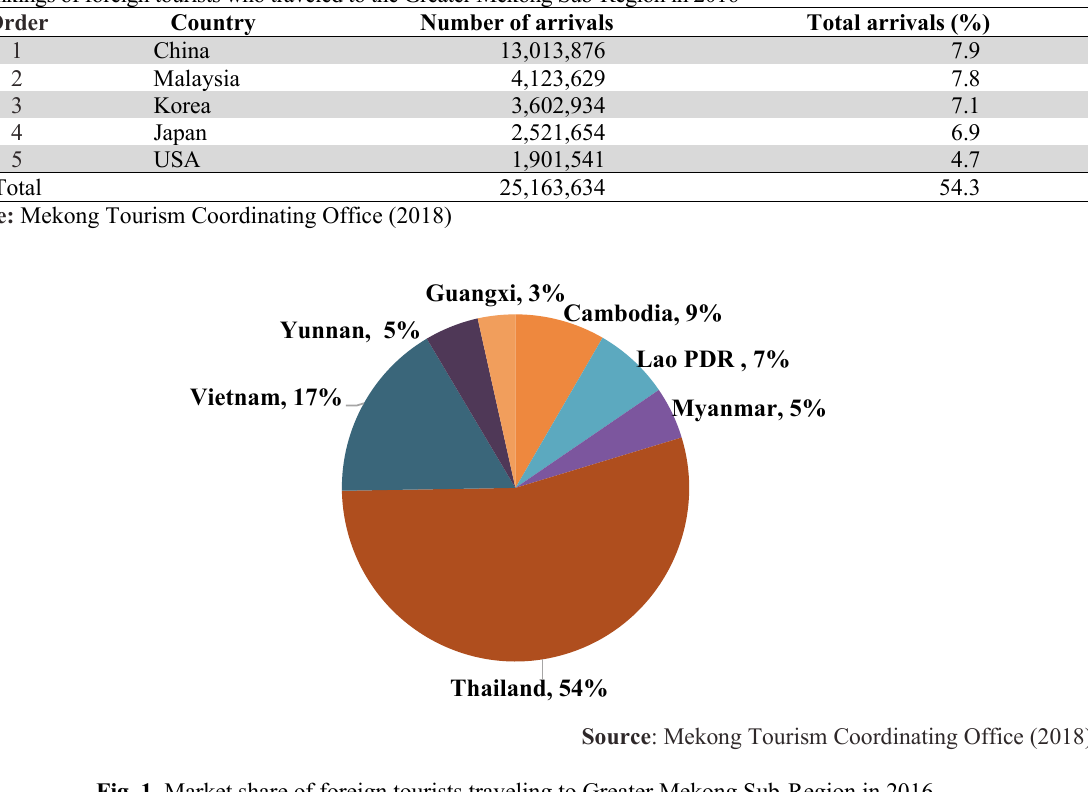
Fig. 1. Market share of foreign tourists traveling to Greater Mekong Sub-Region in